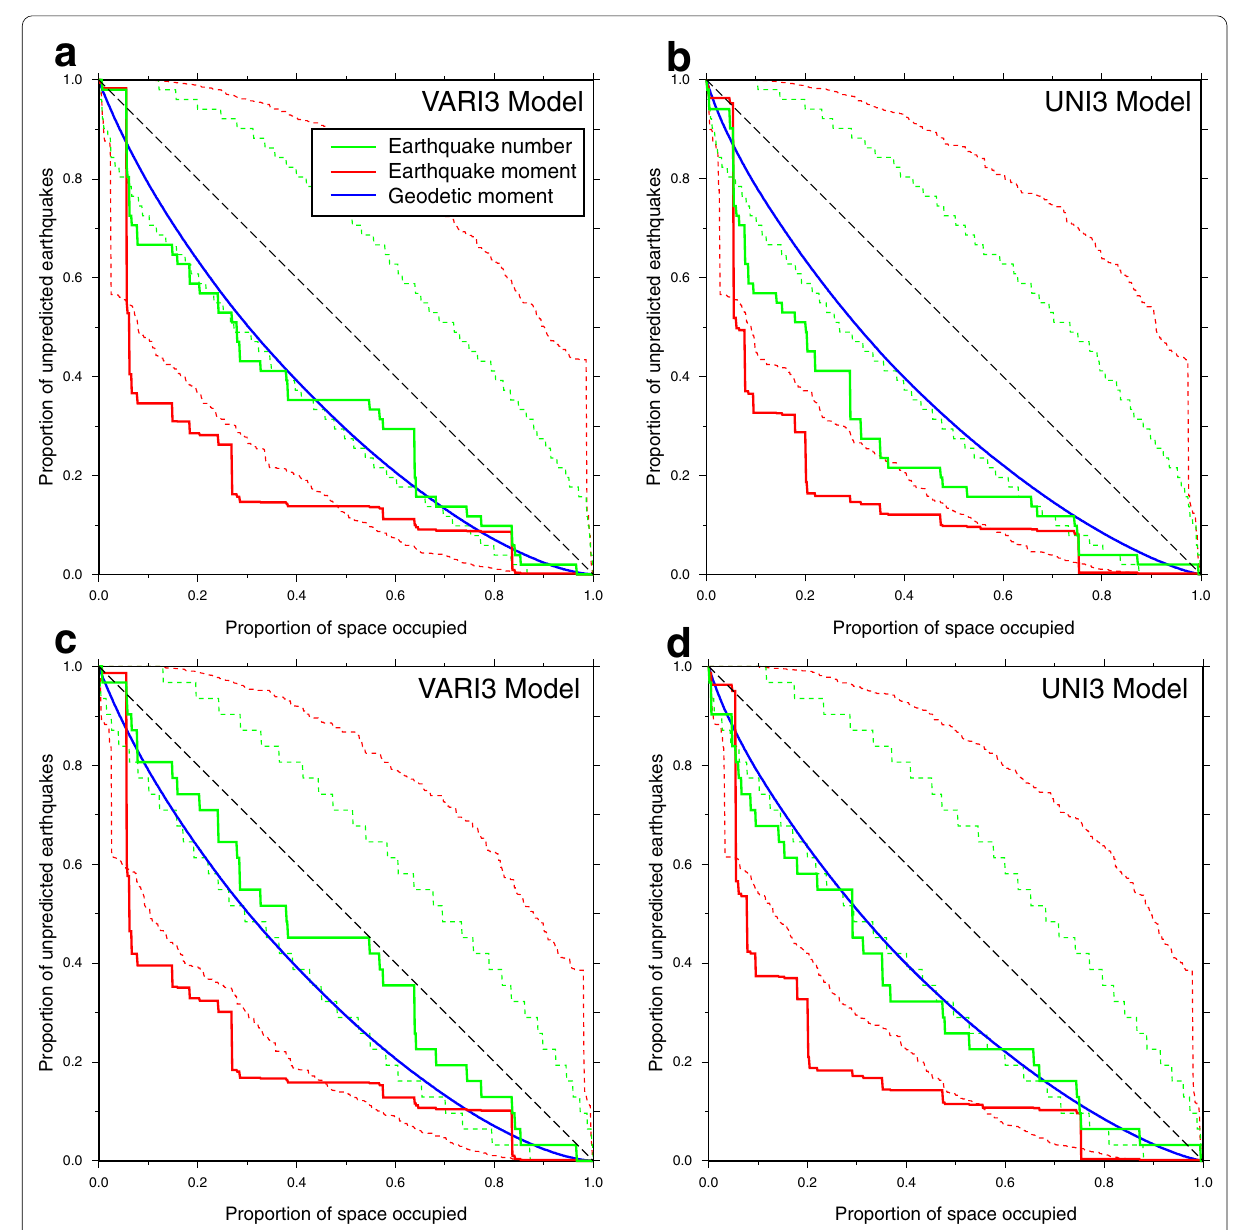
Fig. 7 Comparison of cumulative moment/number between GNSS strain rates and M are the same as those in Fig. 4. a VARI3 model for the original earthquake catalog; b UNI3 model for the original earthquake catalog; c VARI3 model for the declustered earthquake catalog, and d UNI3 model for the declustered earthquake